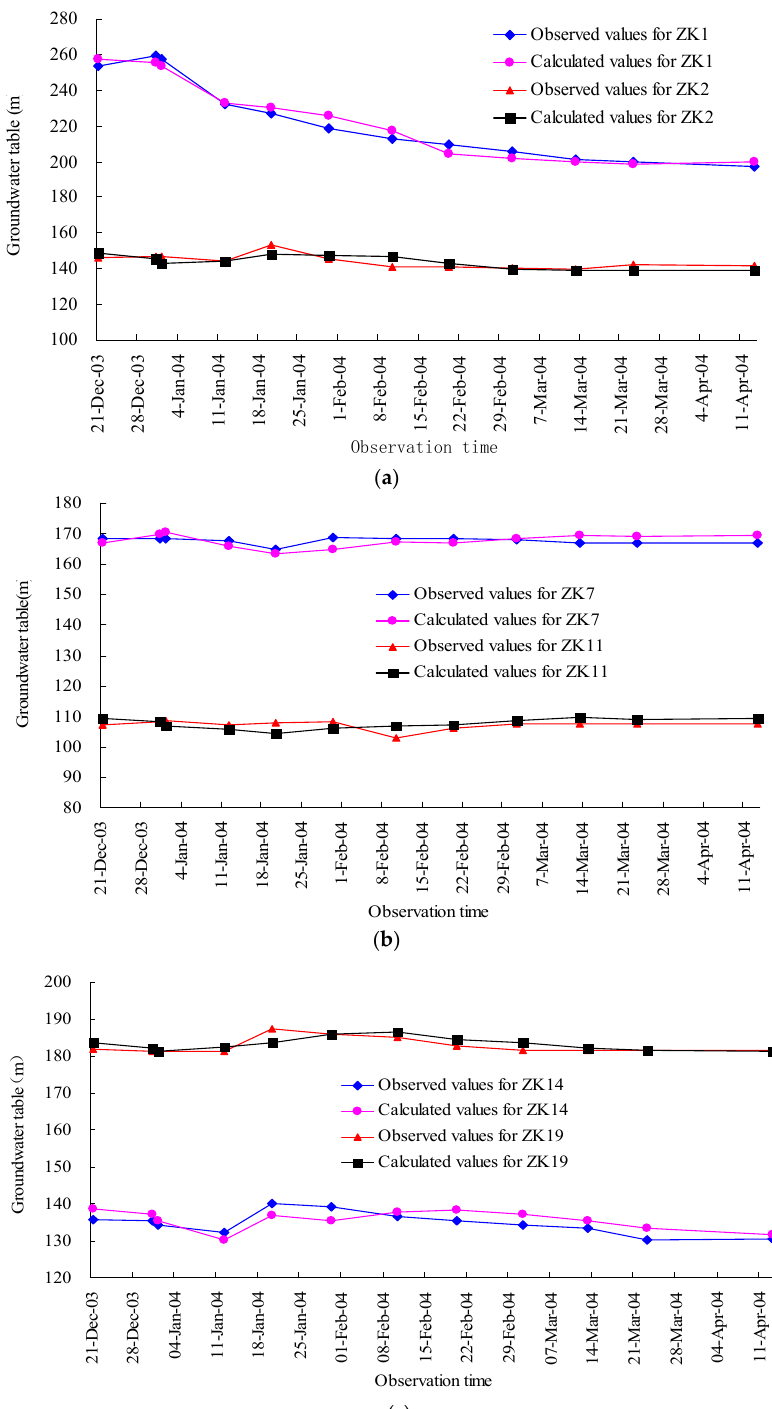
Figure 7. Fitting curves between observed and calculated groundwater levels. ( a ) ZK1 and ZK2. ( b ) ZK7 and ZK11. ( c ) ZK14 and ZK19.